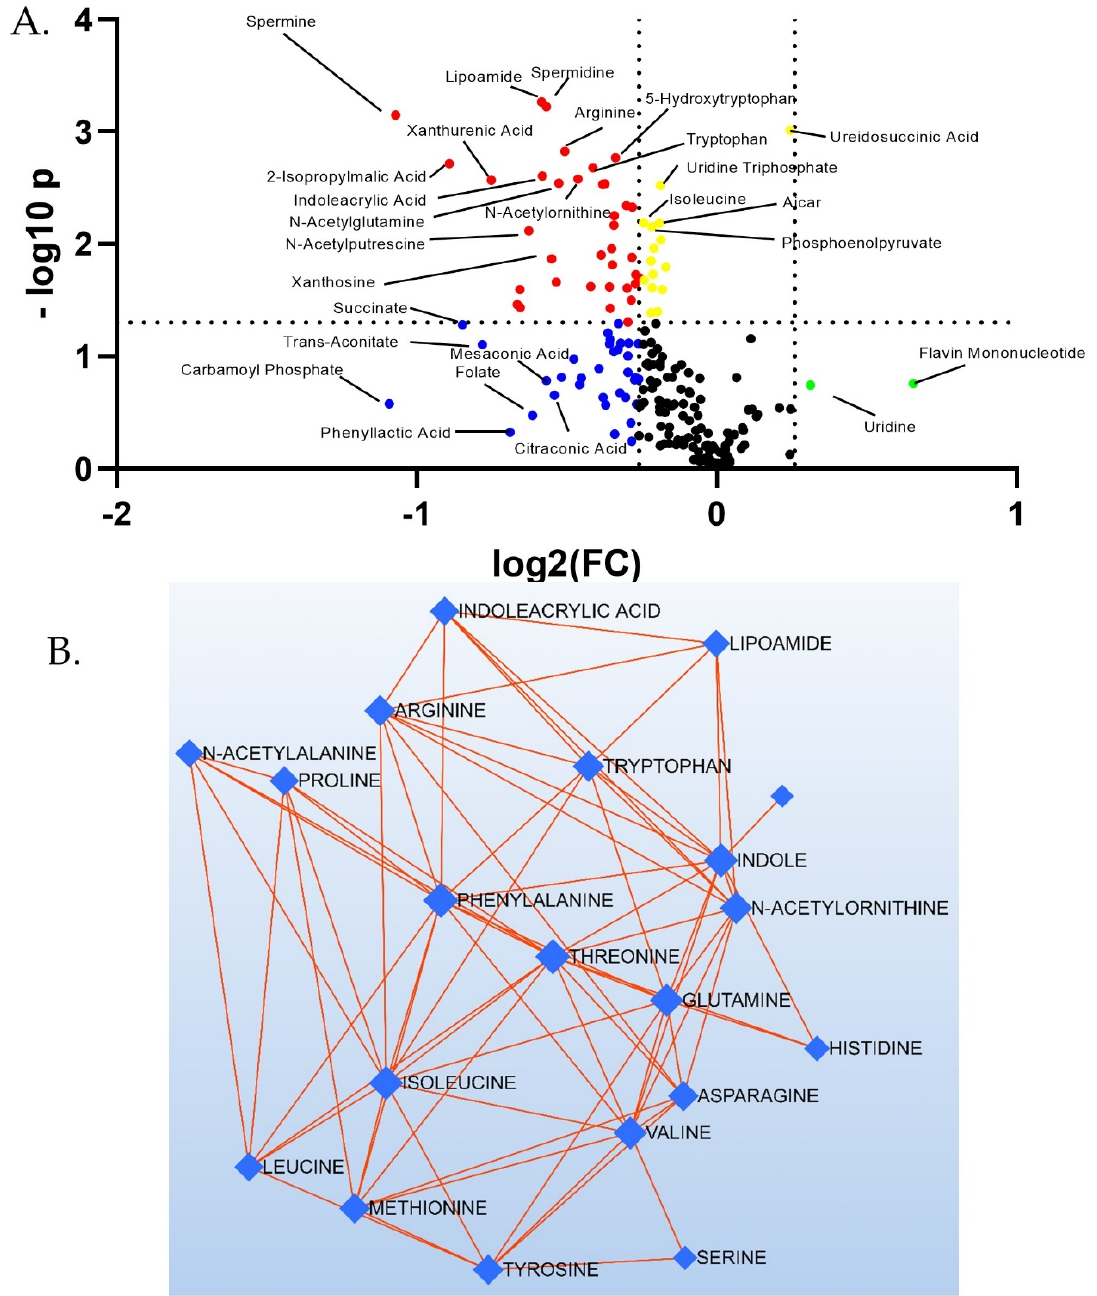
Figure 2. Targeted metabolomics reveals a greater number of down-regulated species. ( A ) Volcano plot of all 207 features: red dots—both p < 0.05 and log2(FC) < − 0.26; yellow dots- p < 0.05 and log2(FC) > − 0.26 and <+0.26; blue dots- p > 0.05 and log2(FC) < − 0.26; black dots- p > 0.05 and log2(FC) > − 0.26 and <+0.26; green dots- p > 0.05 and log2(FC) > +0.26. ( B ) Amino acid network showing the most highly regulated subnetwork. Red edges show positive correlations. The thicker the edge, the stronger the